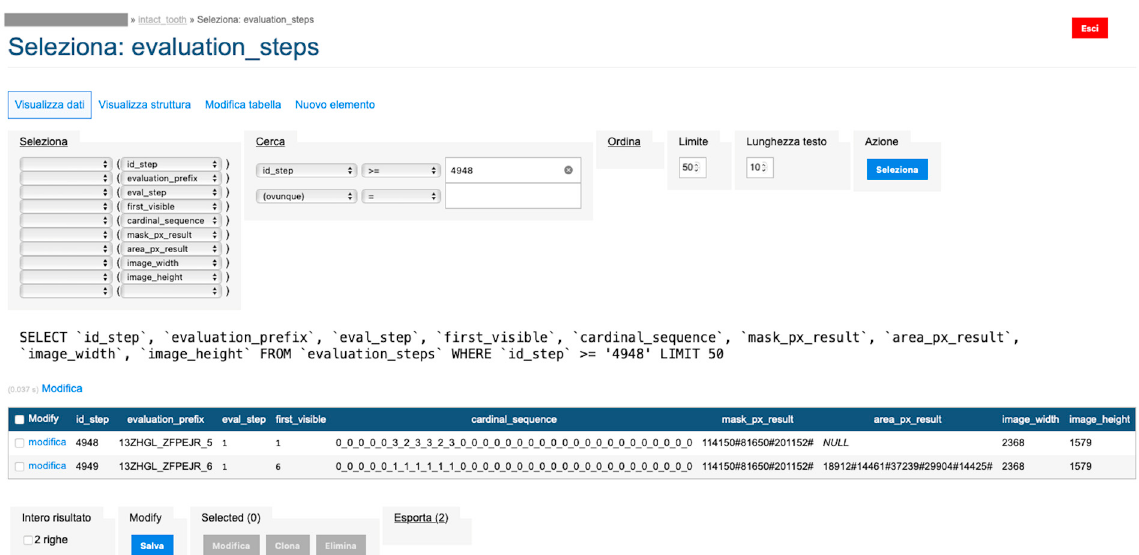
Figure 13. Shows the second part evaluation index process.